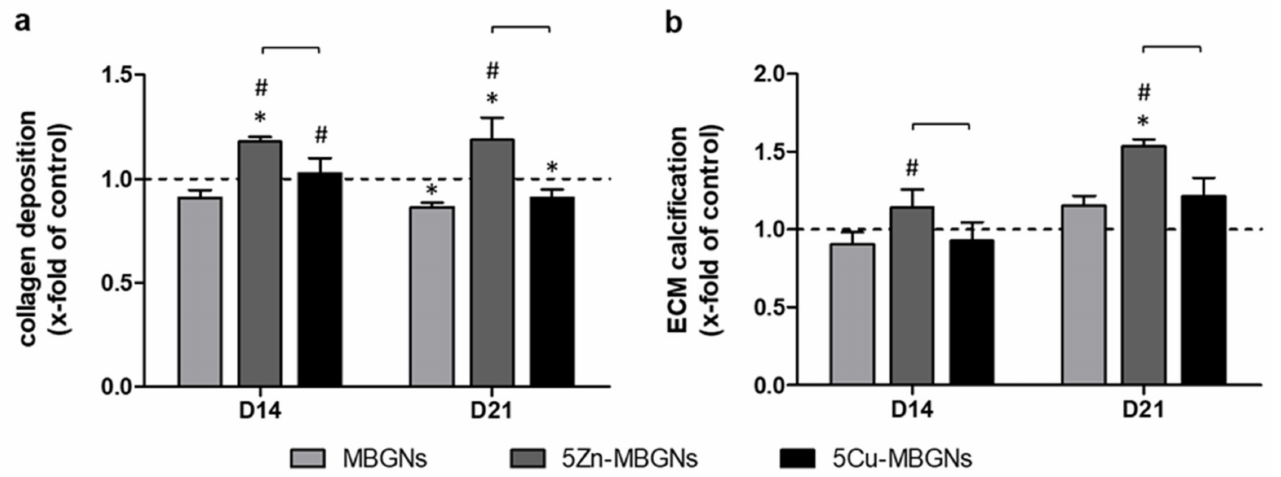
Figure 4. Collagen deposition ( a ) and ECM calcification ( b ) as markers for ECM formation and maturation. Values are normalized to the control group (indicated by the dashed line at y = 1). Significant differences compared to the control group are marked with (*), significant differences compared to MBGNs with (#). Significant differences between the ion-doped MBGNs are highlighted with